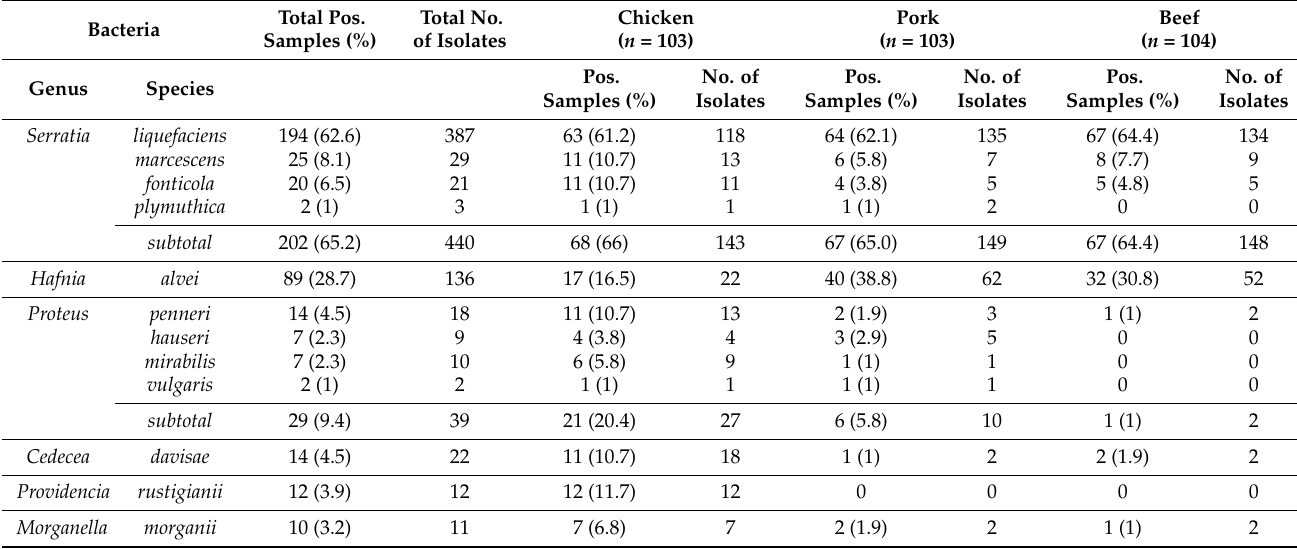
Table 1. Distribution of intrinsic colistin-resistant Enterobacterales isolated from retail chicken, pork, and beef purchased from shops in